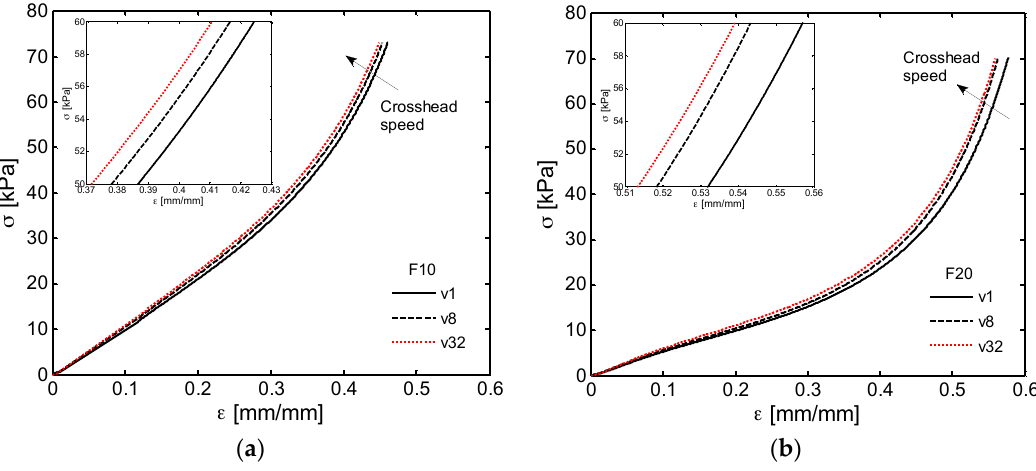
Figure 9. Strain rate dependent stress-strain characteristics of the ( a ) F10; and ( b ) F20 foams ( v 1 = 1 mm/min, v 8 = 8 mm/min, v 32 = 32 mm/min).